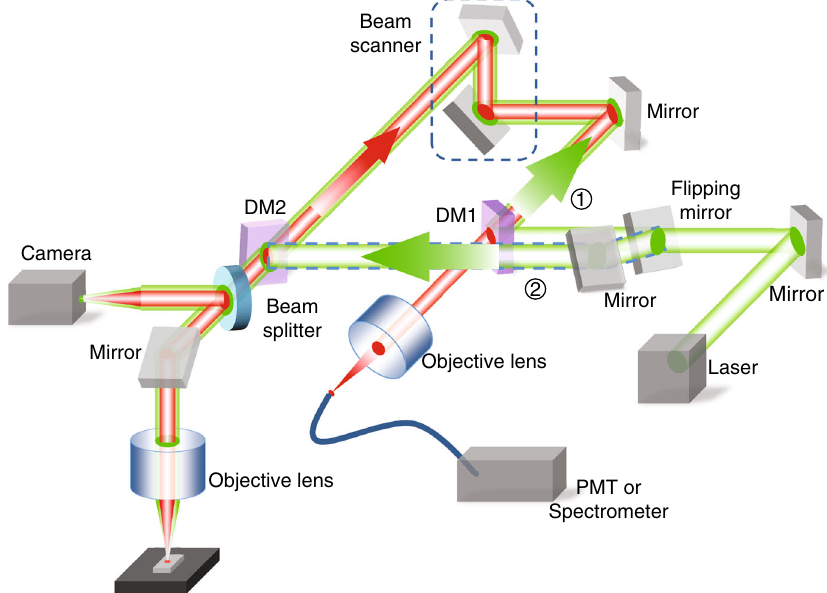
Fig. 4 Illustration of the optical measurement set-up. The optical path following the excitation laser is shown in green and that of the collected PL signal is shown in red . Flipping mirror switches the excitation beam to either (1) double scan mode or (2) single scan mode. DM1 and DM2: dichromatic